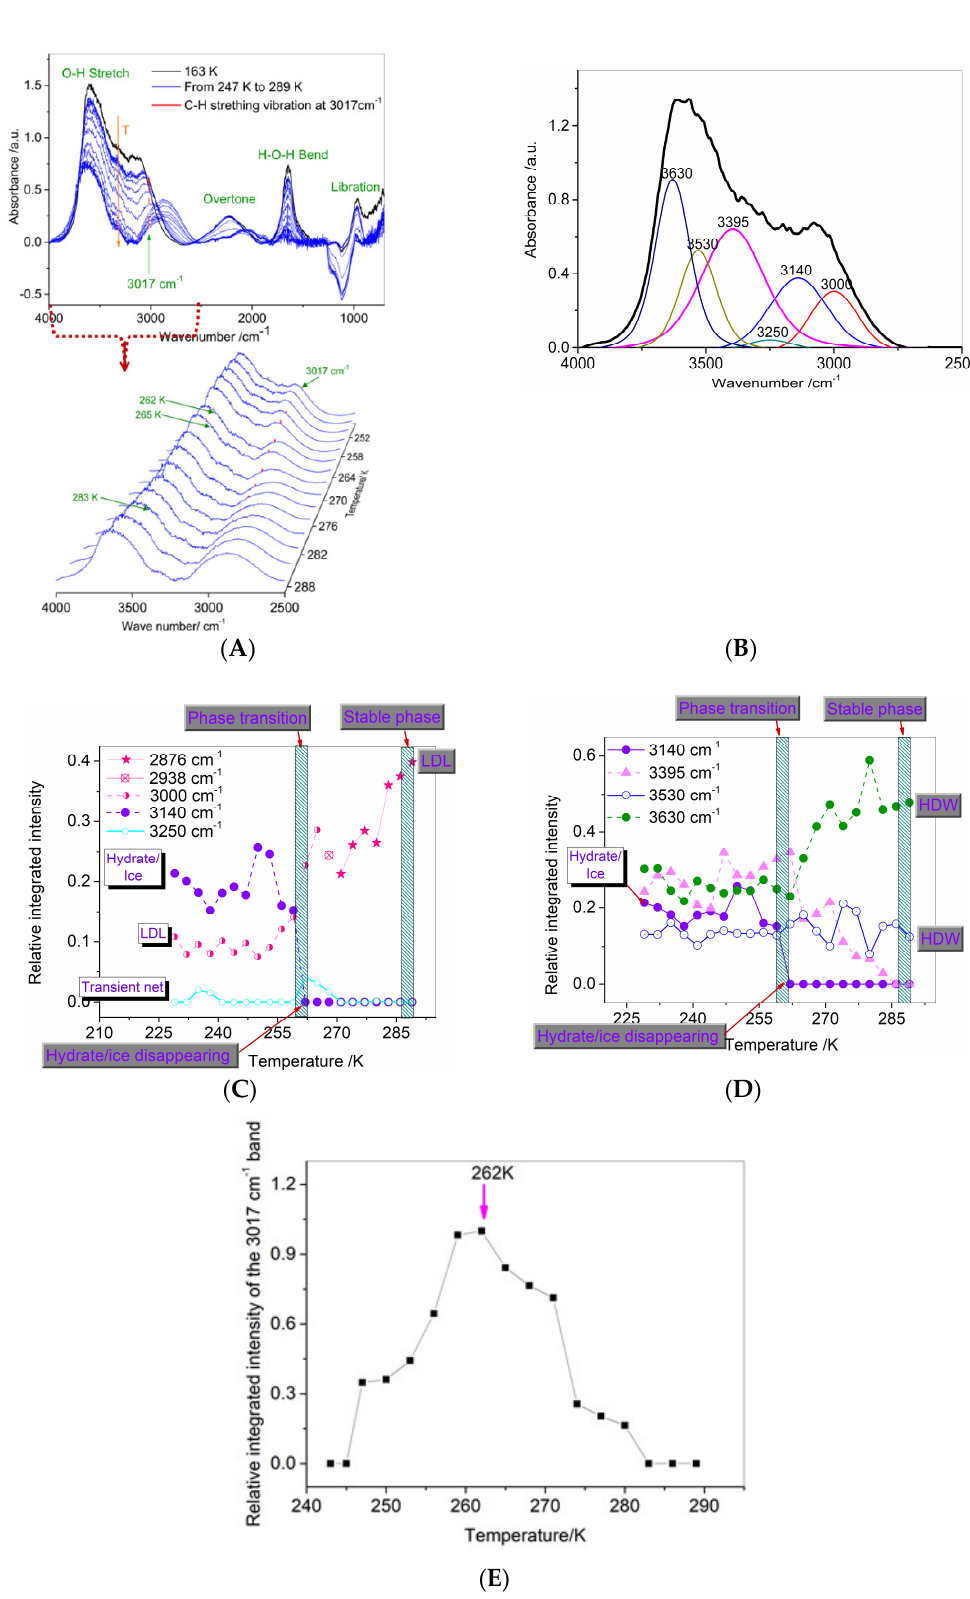
Figure 2. Infrared (IR) absorption signatures of the confined hydrate. ( A ) IR absorption of confined hydrate transitioning at temperatures from 247 K to 289 K.( B ) Gaussian decomposition of the OH stretching band at 247 K. ( C,D ) Temperature evolution of fitting peaks relative integrated intensities. ( E ) Temperature evolution of the relative integrated intensity of the 3017 cm −1 band. The relative integrated intensity of the 3017 cm −1 band is the ratio of the integrated intensity of the 3017 cm −1 band at different temperatures to the one at 262K.